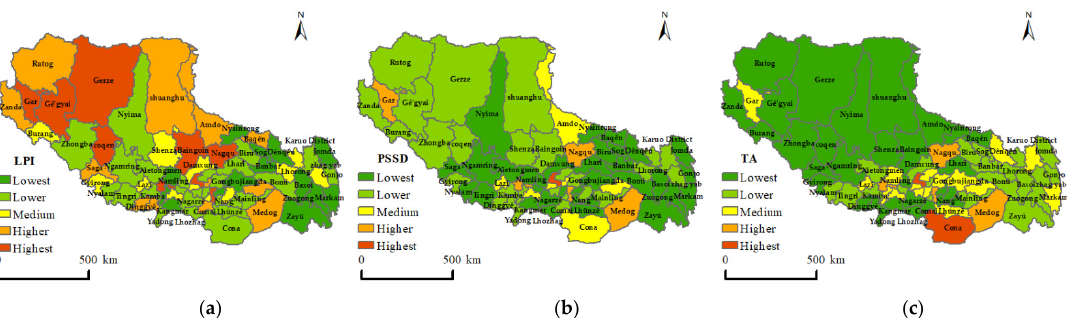
Figure 8. LPI, PSSD, and TA index’s spatial distribution maps by county. ( a ) LPI; ( b ) PSSD; and ( c ) TA LPI. LPI is largest patch index; PSSD is standard deviation of patch size; TA is the total area of patch.